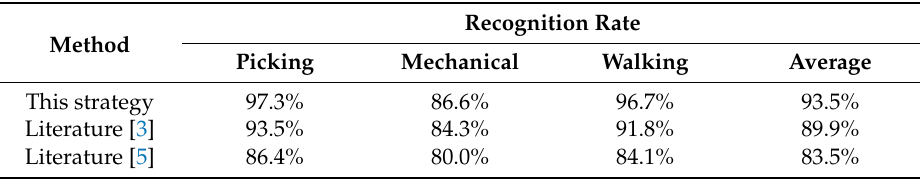
Table 6. Comparison of Recognition performance of each cognitive strategy.